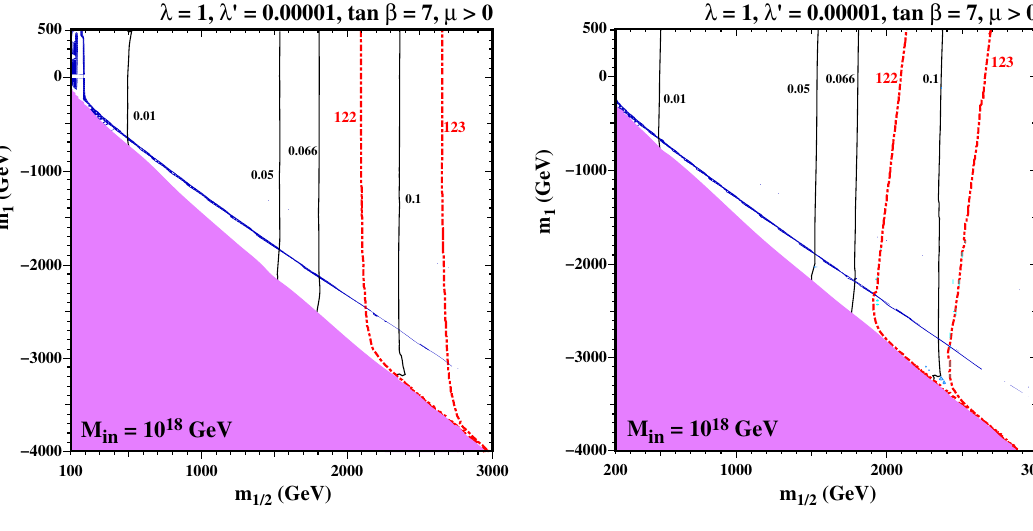
A b = m 1 , A λ = m 1 , A λ (cid:2) = 0, B H = m 1 , and B (cid:3) = 0. In both panels tan β = 7, λ = 1 and λ (cid:2) = 10 − 5 . The shadings and contour colors are the same as in Fig. 1. The width of the relic density region ( shaded blue ) has been enhanced for better visibility